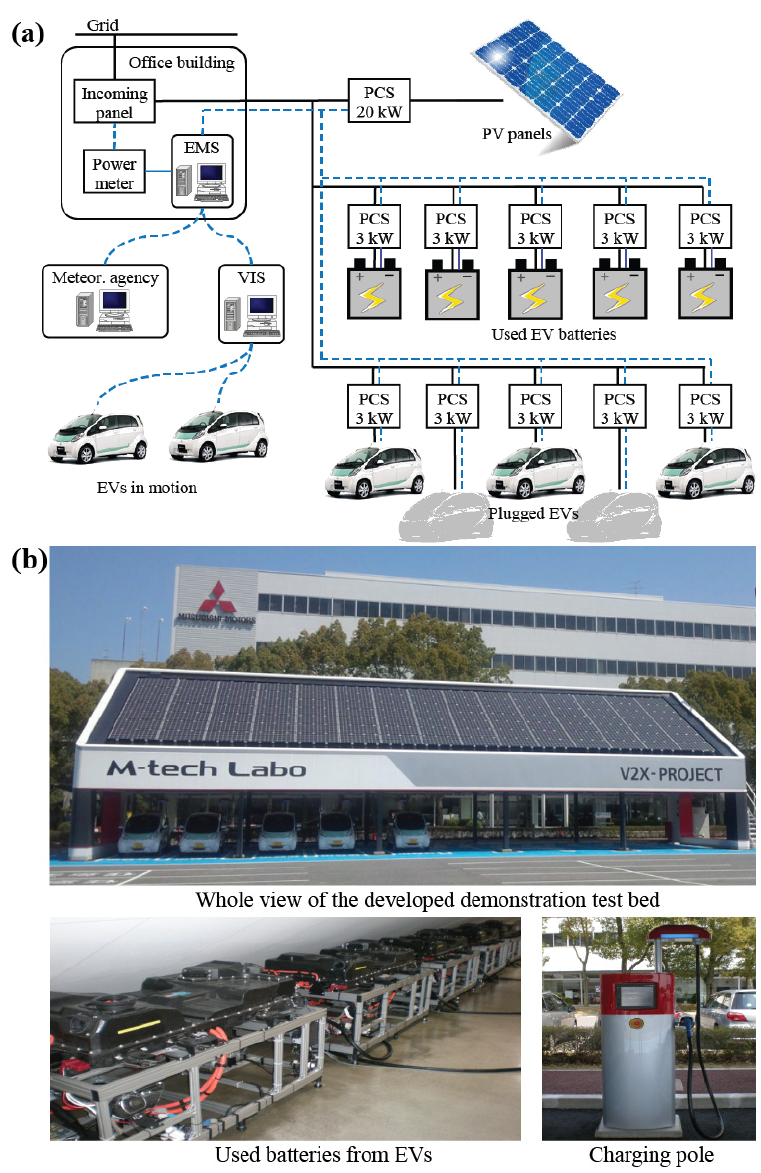
Figure 7. The developed demonstration test bed: ( a ) schematic diagram of the system; ( b ) overview of the developed system including PV panels and